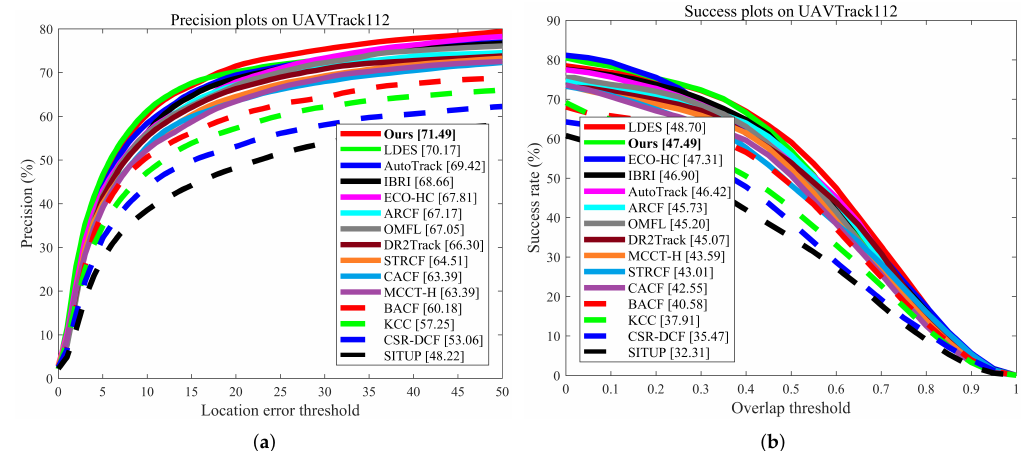
Figure 7. Overall evaluation on the UAVTrack112 [25] benchmark. ( a ) Precision plots. ( b ) Suc- cess plots.